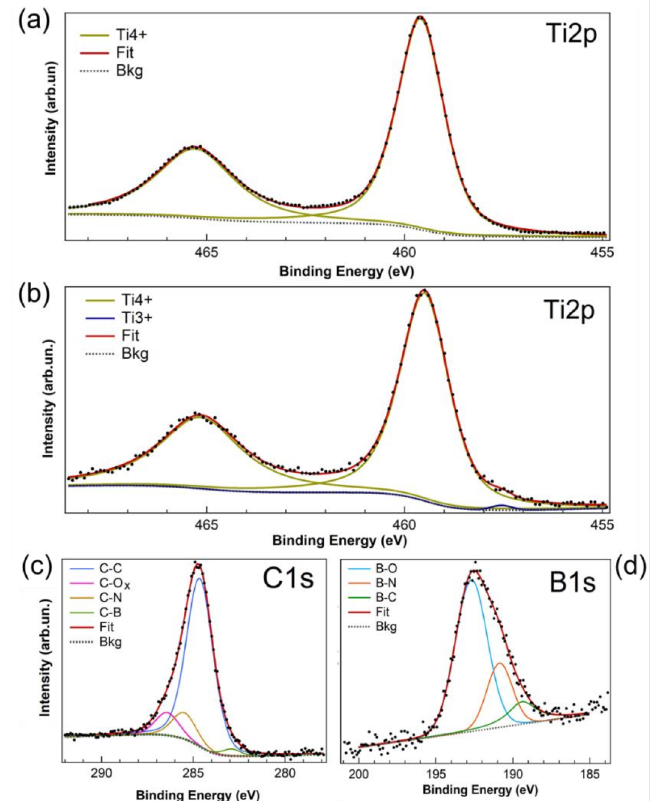
Figure 5. Ti2p XPS spectra for ( a ) TiO 2 sample and ( b ) TiO 2 -BCN sample. C1s ( c ) and B1s ( d ) spectra for TiO 2 -BCN sample. Experimental data (dots), Shirley background is represented by a grey dotted line, the fitting curve for each measurement is in red, and single fitting components, as described in the